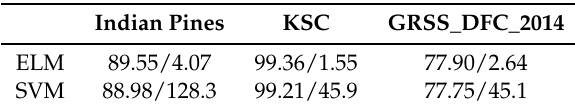
Table 4. The OA (%)/running time (s) by ELM and SVM.